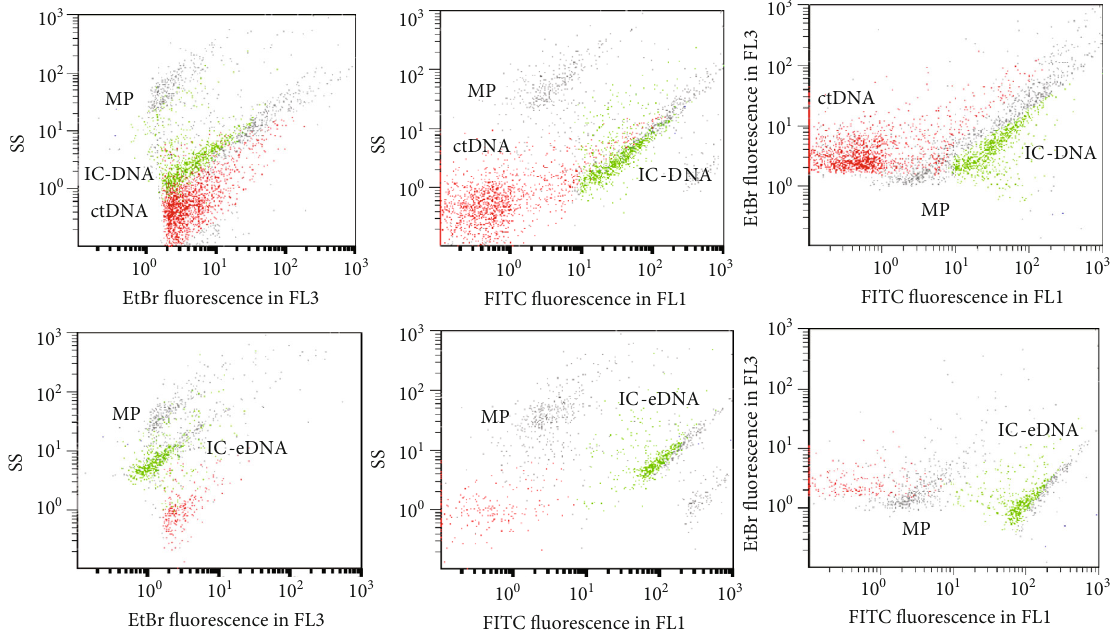
Figure 2: Detection of immune complexes DNA-anti-DNA antibodies (IC-DNA). In the upper histograms, a serum sample of SLE incubated with 20 μ g/ml ctDNA and in the lower histograms before incubation. SS is the side scatter; FL3 (620nm) is fl uorescence of DNA stained by EB and FL1 (525nm) fl uorescence due to antibody labeling by FITC-conjugated anti-human globulin. IC-eDNA, microparticles (MPs), and some free DNA already were present in the serum sample, but after incubation with ctDNA, the rate of IC-DNA increased signi fi cantly. The discriminator was EB fl uorescence; only events stained by EB are shown. For each series of experiments, a gate was built around IC-DNA in order to quantify events. The parameters of this gate were de fi ned by the SS, FITC fl uorescence of the second antibody in FL1, and fl uorescence of DNA stained by EB in